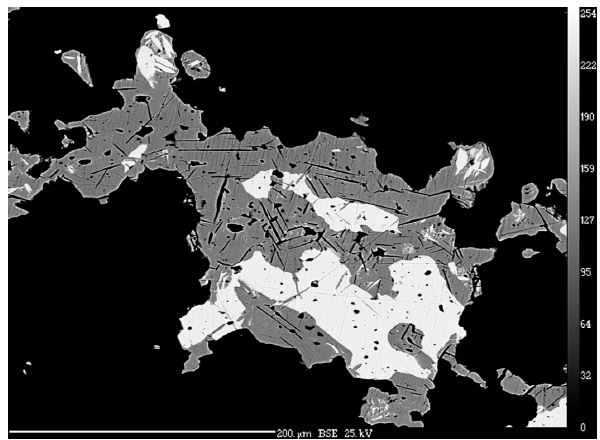
Figure 34. Se vs. S ( apfu ) graph of chalcopyrite and eskebornite from various localities.